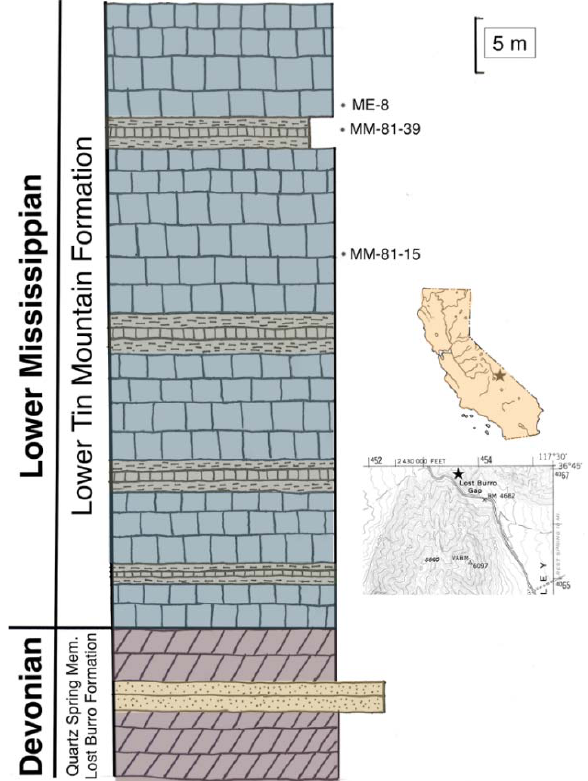
Figure 1. Stratigraphic section, north side of Lost Burro Gap, Inyo County, California. Upper inset map shows the location of the stratigraphic section on a map of California (star). Lower inset map shows the location of a section at Lost Burro Gap (star). Three ostracod-bearing fossil localities are indicated on the stratigraphic section (MM-81-15, MM-81-39 and ME-8). Key to the color scheme: blue-grey , limestone; grey , calcareous shales and thin-bedded limestones; yellow , dolomitic sandstone; light purple , dolostone. Scale bar for section = 5